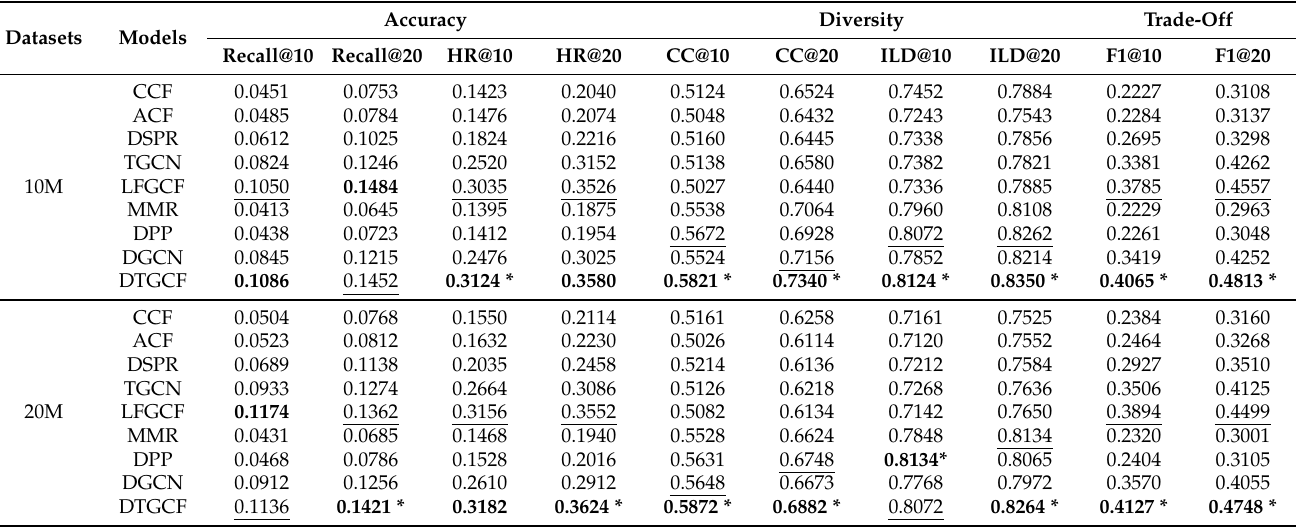
Table 2. Overall performance comparison on two datasets in terms of accuracy, diversity, and trade- off metrics. The best result is in bold, and the second best one is marked with an underline. Statistical tests are conducted between the best result and the second best result. If significant differences are detected ( p -value < 0.05), the corresponding best result is marked with a symbol